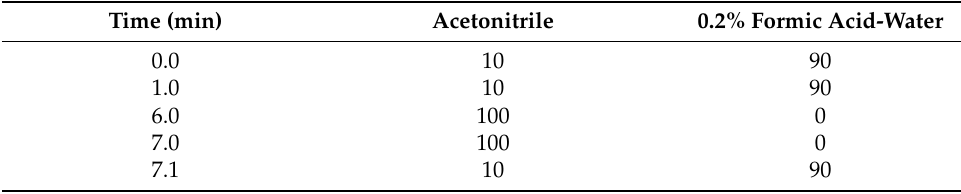
Table 12. Linear gradient elution procedure of bosentan and hydroxybosentan. Time (min) Acetonitrile 0.2% Formic Acid-Water